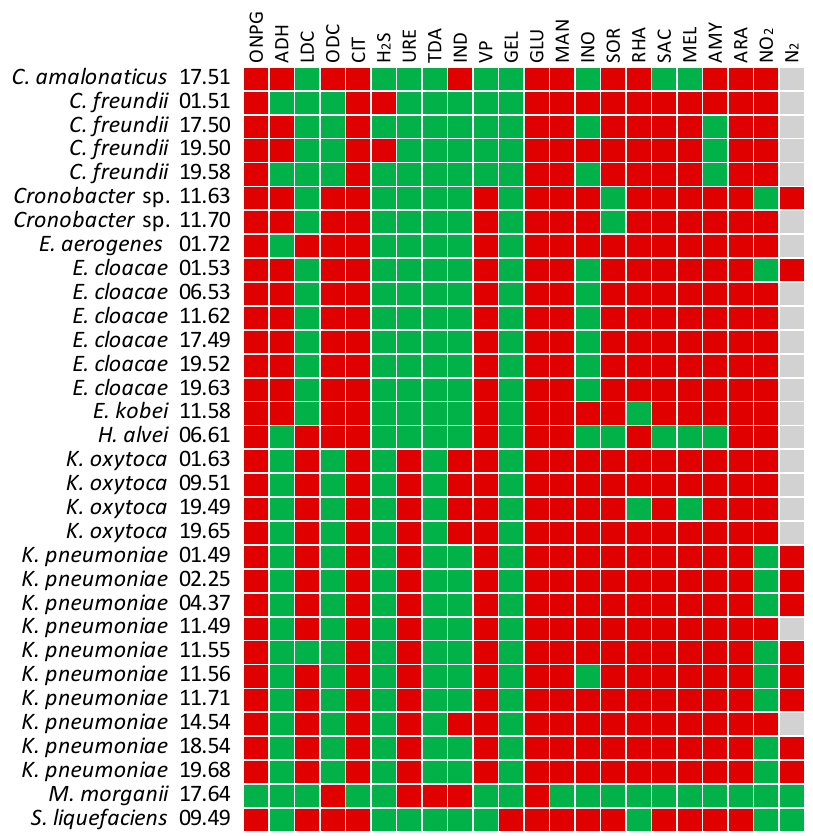
Figure 5. Biochemical reaction profiles of NECE isolates in the API 20 E assay: β -galactosidase (ONPG), arginine dihydrolase (ADH), lysine decarboxylase (LDC), ornithine decarboxylase (ODC), citrate utilization (CIT), production of hydrogen sulfide (H 2 S), urease (URE), tryptophan deaminase (TDA), indole (Kovac’s test, IND), acetoin (Voges-Proskauer test, VP), gelatinase (GEL), fermentation of glucose (GLU), mannitol (MAN), inositol (INO), sorbitol (SOR), rhamnose (RHA), sucrose (SAC), melibiose (MEL), amygdalin (AMY), arabinose (ARA), and reduction of nitrates to nitrites (N 2 O) or nitrogen (N 2 , tested only in case of negative N 2 O). Colors: red, positive; green,